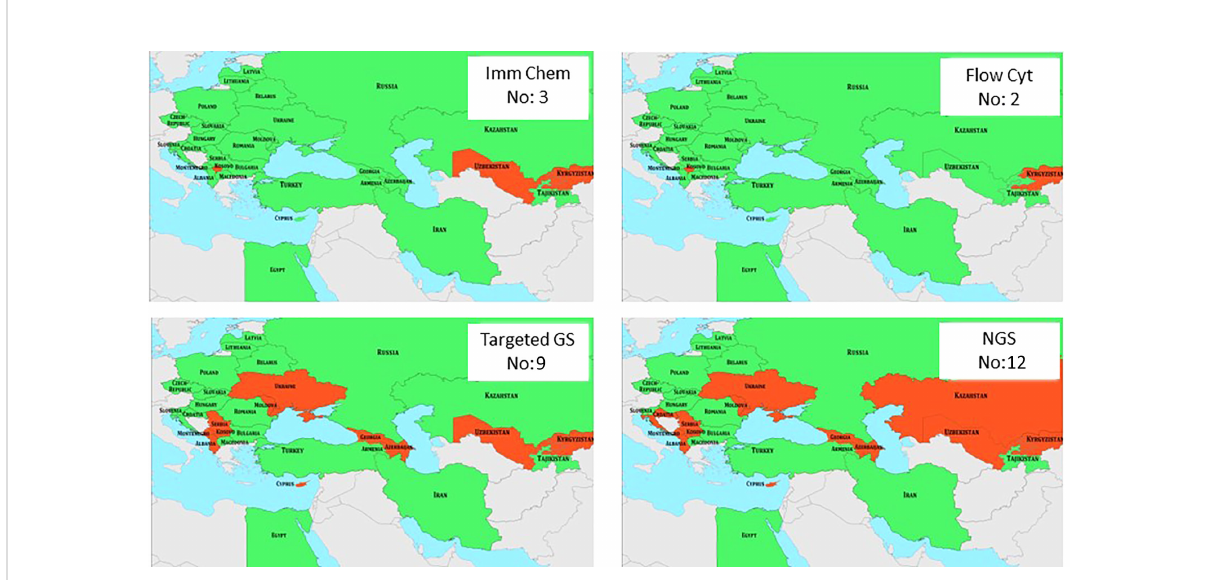
FIGURE 6 Availability of basic diagnostic parameters in J Project countries is shown in green. Red indicates the lack of various parameters. Numbers in insets indicate the number of countries that are missing various diagnostic measures. Imm Chem, immunochemistry; Flow Cyt, fl ow cytometry; GS, gene sequencing; NGS, new generation